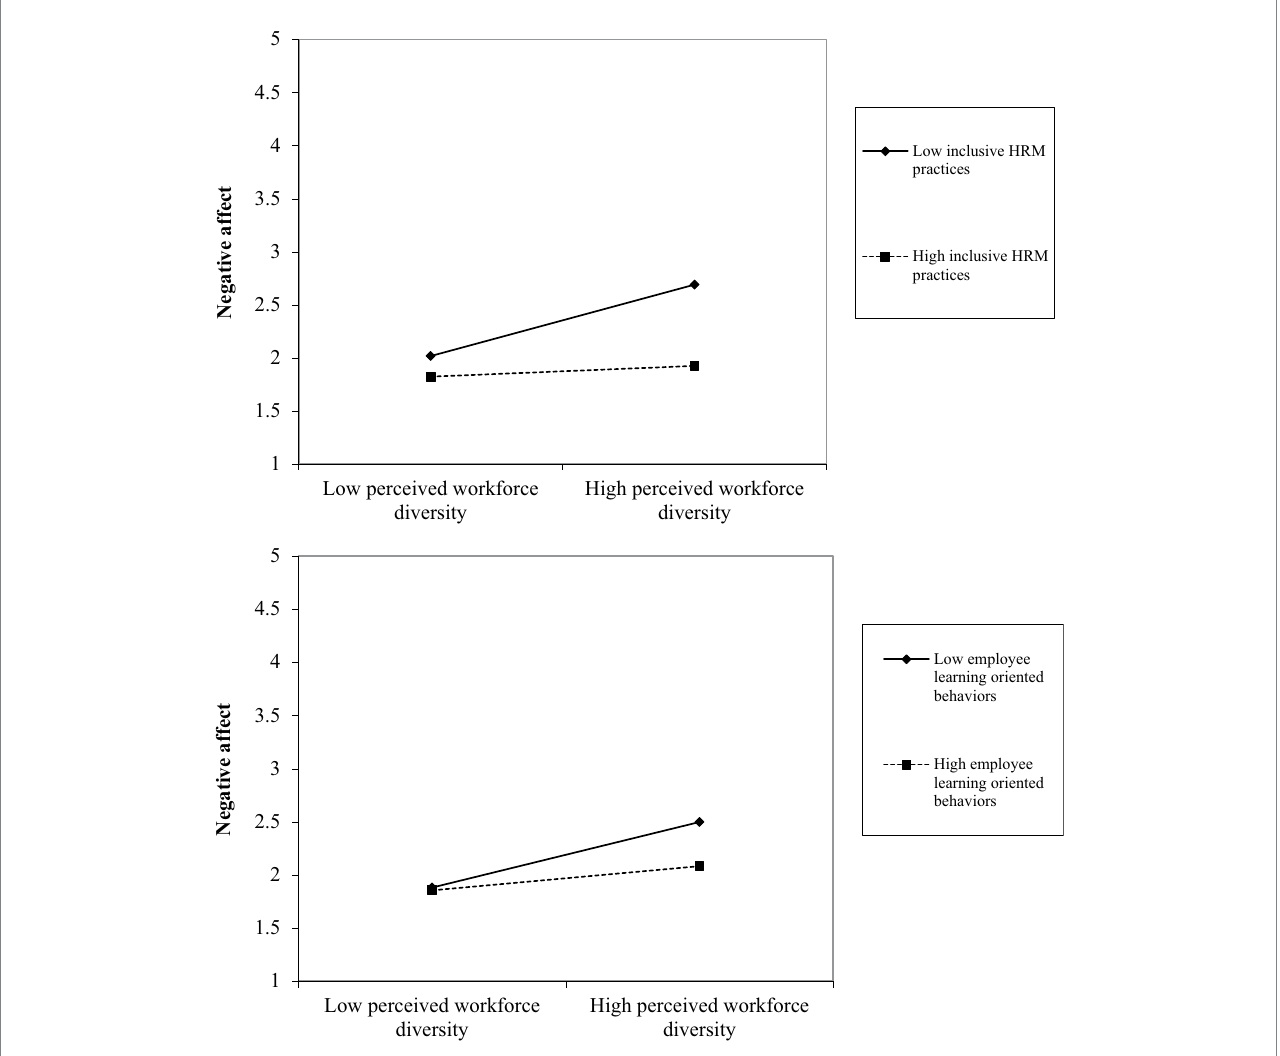
FIGURE 3 (A) The two-way interaction between workforce diversity and inclusive HRM practices on employee negative affect. (B) The two-way interaction between workforce diversity and employee learning behaviors on employee negative